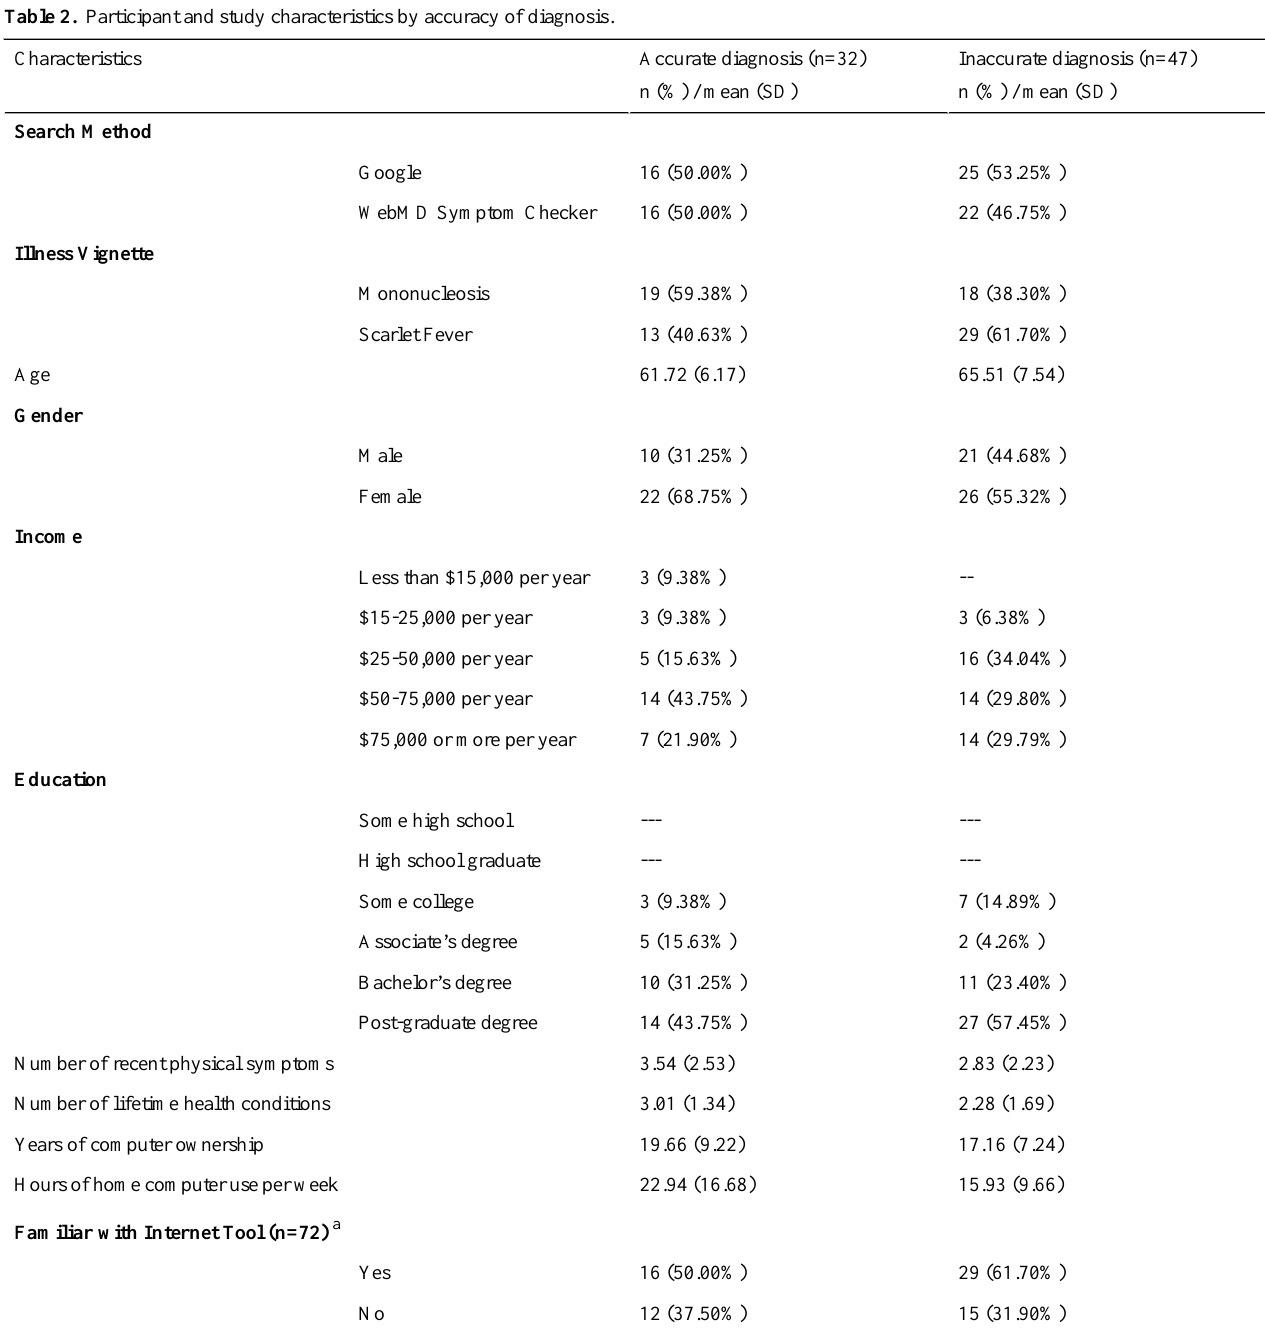
Table 2. Participant and study characteristics by accuracy of